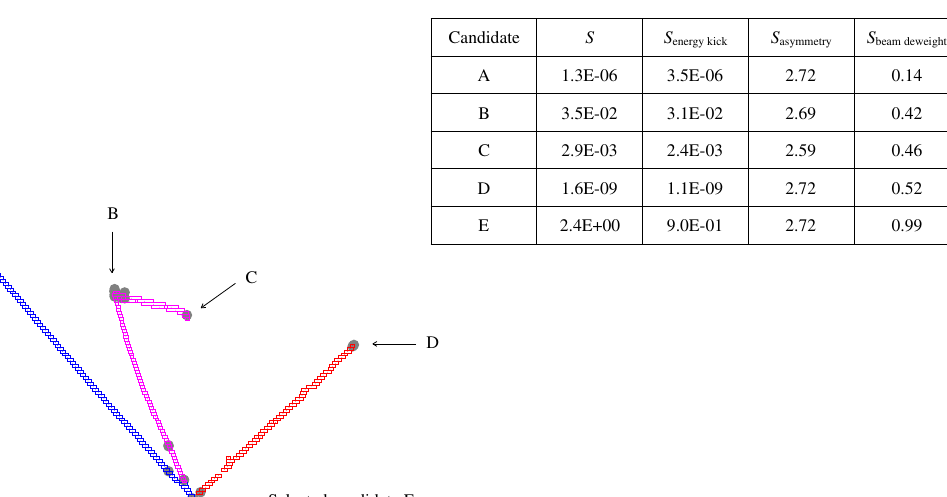
ogy. To select the neutrino interaction vertex, each candidate is assigned ascore.Thescoresareindicatedforanumberofcandidatesandabreak- down of each score into its component parts is